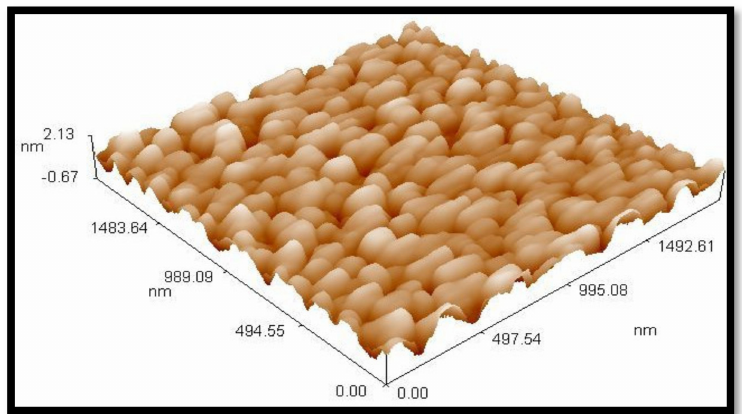
Figure 7. Atomic force microscopy (AFM) three-dimensional (3D) surface profile of nanosilica.